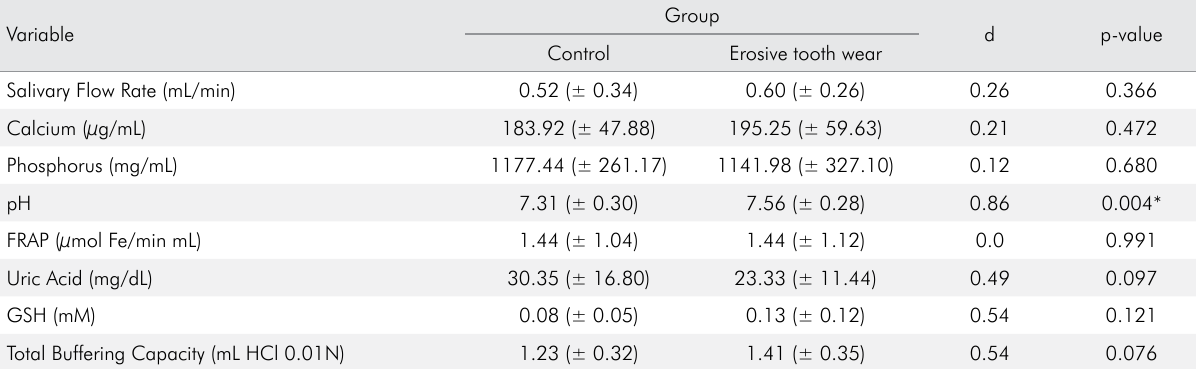
Table. Averages, standard deviations (±), and effect size ( d ) of each salivary evaluation.